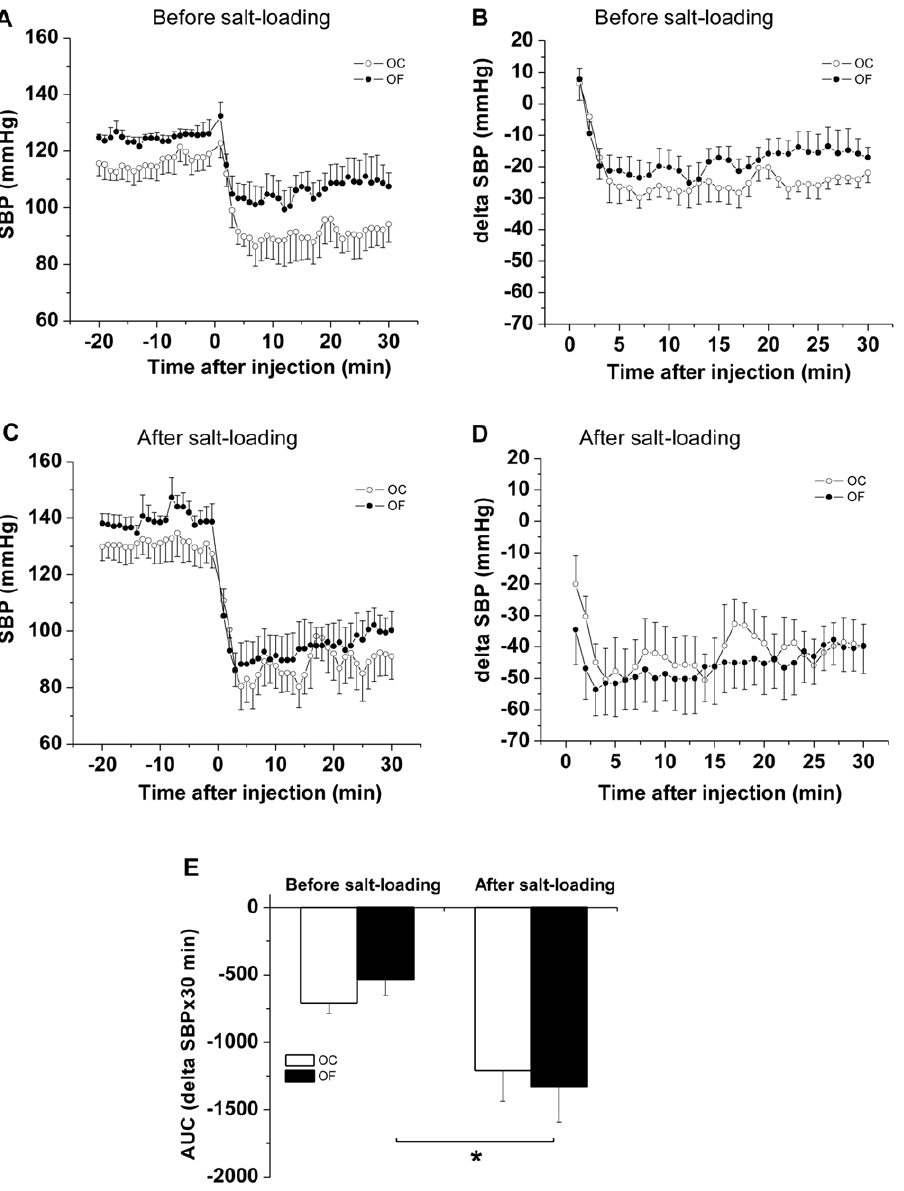
Figure 5. Male offspring of fat-fed dams had a greater depressor response following adrenergic blockade after salt-loading than before. (A, C) SBP response and delta SBP (B, D) in response to combined adrenergic blockade before (A, B) and after (C, D) salt-loading in adult male offspring from dams fed a control (OC, open circles) or a fat diet (OF, closed circles). (E) Area under the curve of delta SBP in response to combined adrenergic blockade before and after salt-loading in adult male offspring from dams fed a control (unfilled bars) or a fat diet (filled bars). n=5 per group, * P # 0.05 versus before salt-loading). Error bars represent mean 6 SEM.